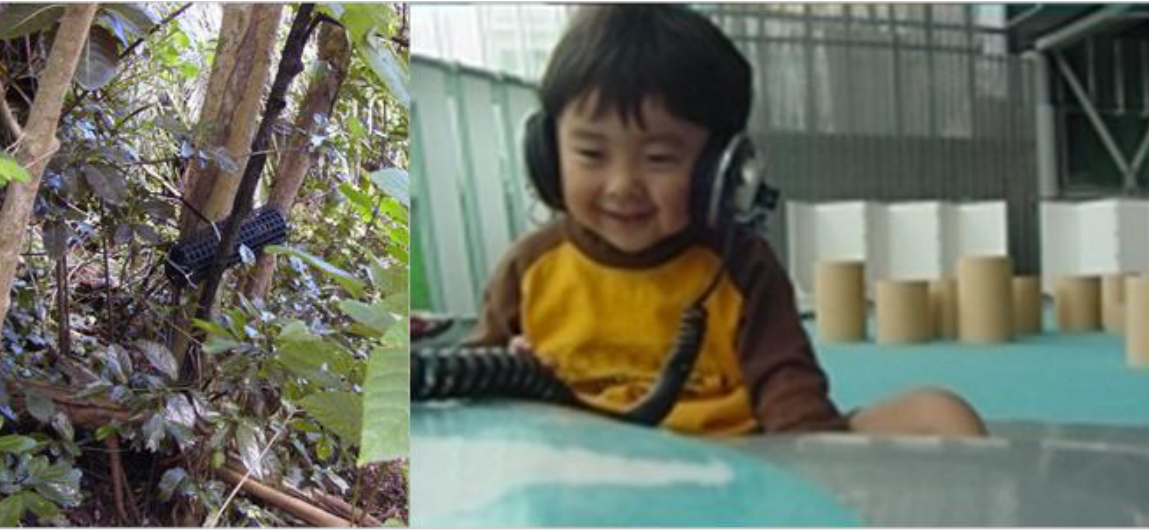
Figure 6. Live sound from a subtropical forest on Iriomote Island is collected via a pair of networked microphones that are wrapped in a thick black sheet of waterproof sponge and a plastic hard mesh, then tied to a tree trunk; such live sounds have been streamed to users in real time, 24 h a day since 1997. Photo (right) by SoundBum